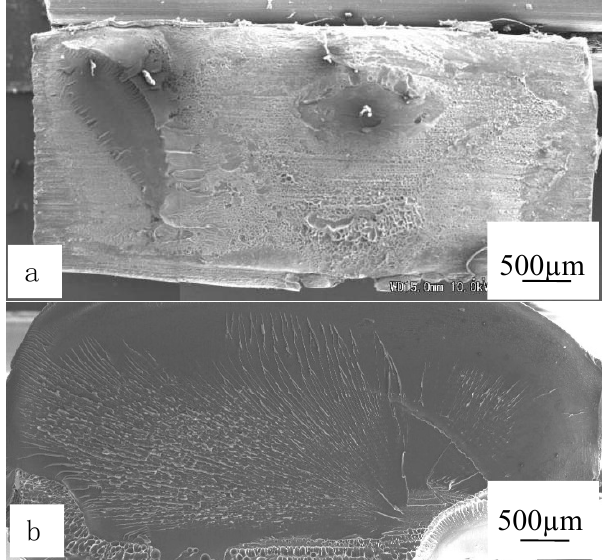
Figure 13. SEM images of rupture surfaces under welding time of 3.0 s. ( a ) and ( b ) are at welding pressures of 0.1 MPa and 0.4 MPa. Adapted from Reference [149].